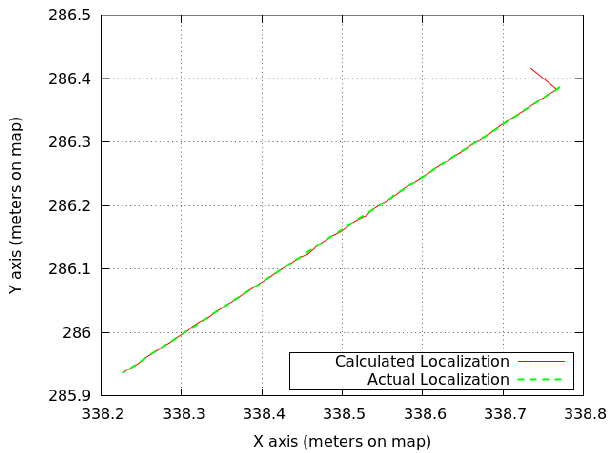
Figure 11. Localization curve with lock implemented on satellites during